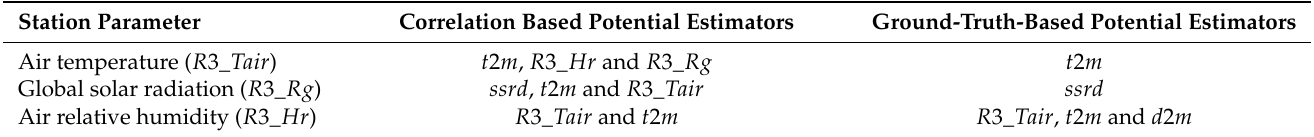
Figure 6. The correlation heatmap and hierarchical clustering of the station and ERA5-Land parameters. Table 3. Potential estimators of meteorological